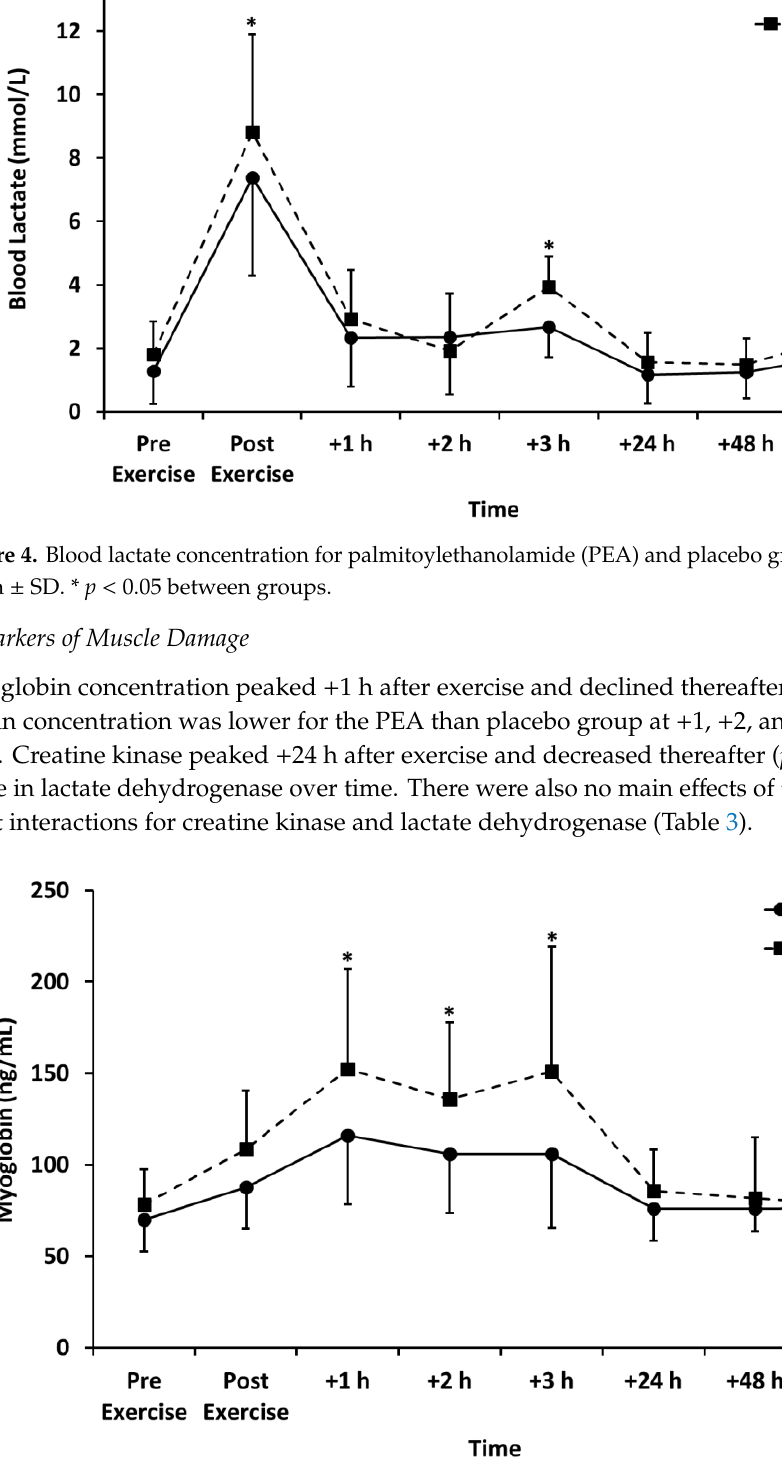
Figure 5. Myoglobin concentration for palmitoylethanolamide (PEA) and placebo groups. Values are mean ± SD. * p < 0.05 between groups.